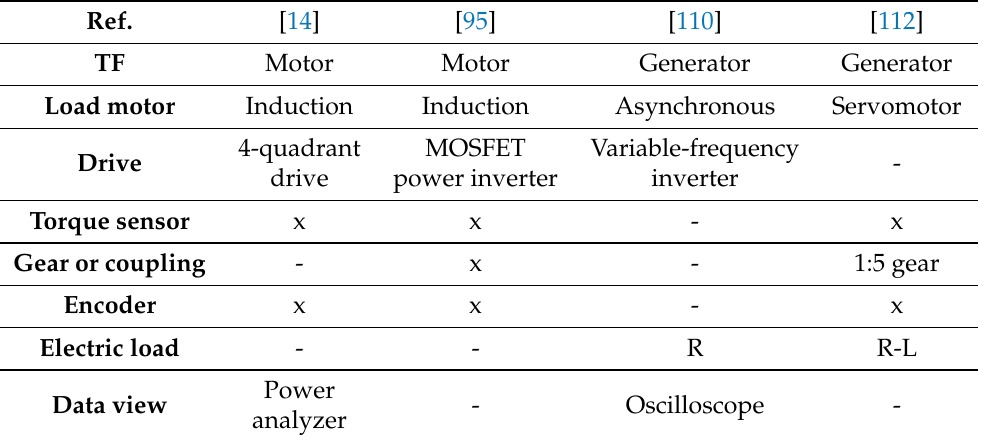
Table 7. Components involved in FOC